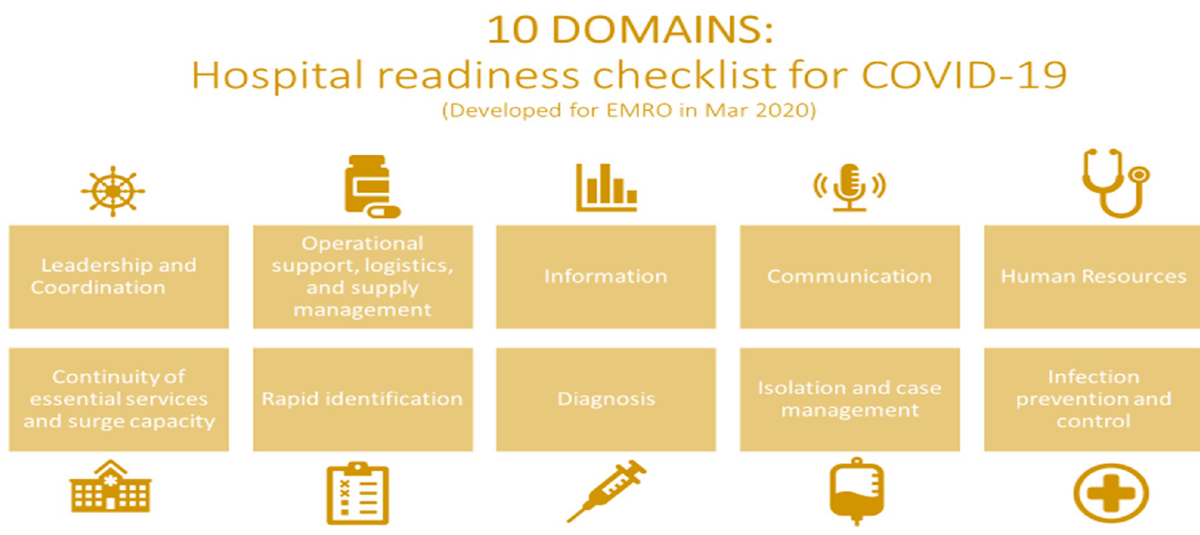
Fig 1. Hospitals’ readiness checklist for COVID-19 (WHO/EMRO,